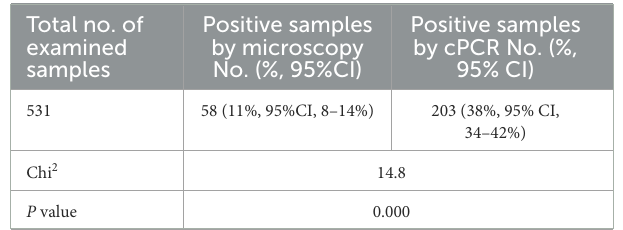
TABLE 3 Parasitological and molecular prevalence of Piroplasma spp. infections in